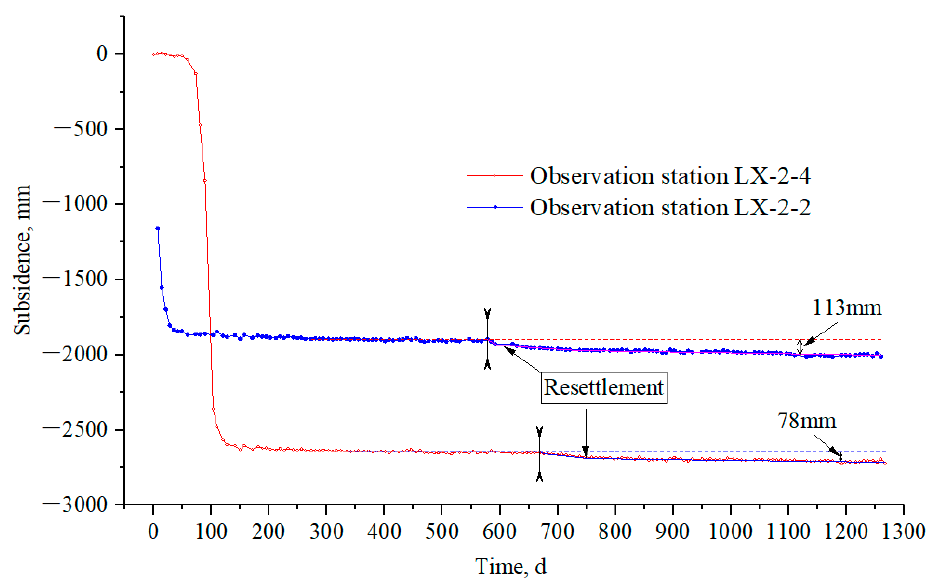
Figure 7. Settlement curves of GNSS observation stations.